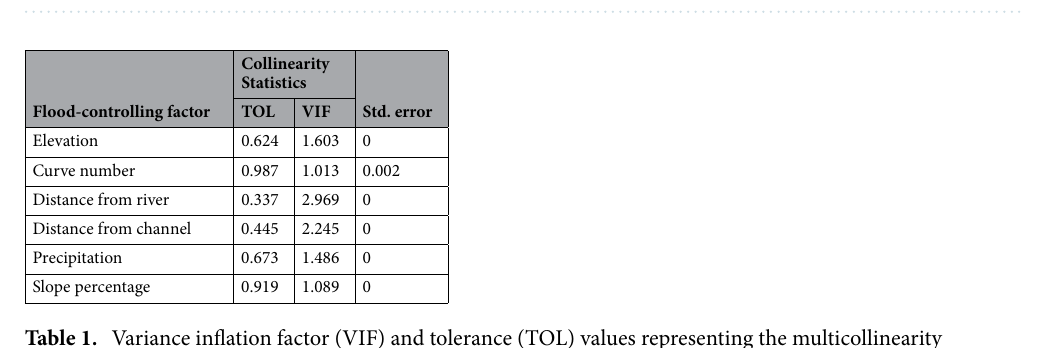
Table 1. Variance inflation factor (VIF) and tolerance (TOL) values representing the multicollinearity between selected flood-controlling factors.